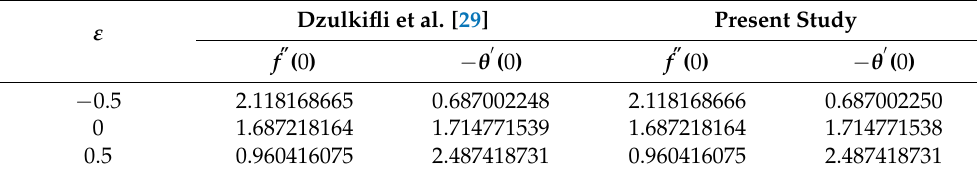
Table 1. Comparison of the values of f (cid:48)(cid:48) ( 0 ) and − θ (cid:48) ( 0 ) for various ε when σ = 0 and ϕ = 0. ε